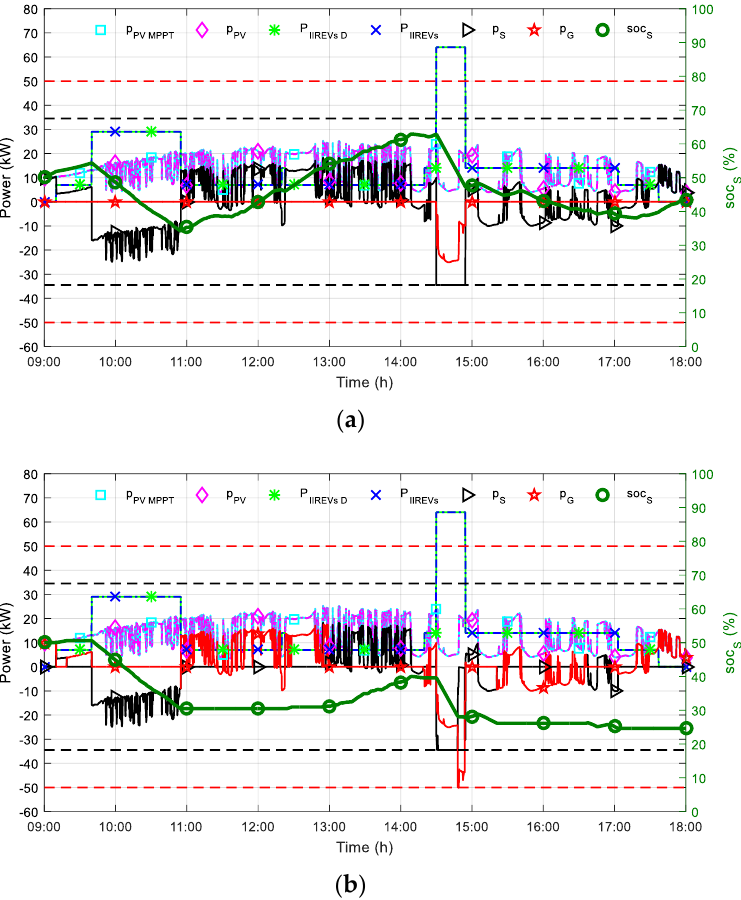
Figure 14. Power flow and storage state of charge in ( a ) “Sim w/o opt” and ( b ) “Sim with opt”— case 3.